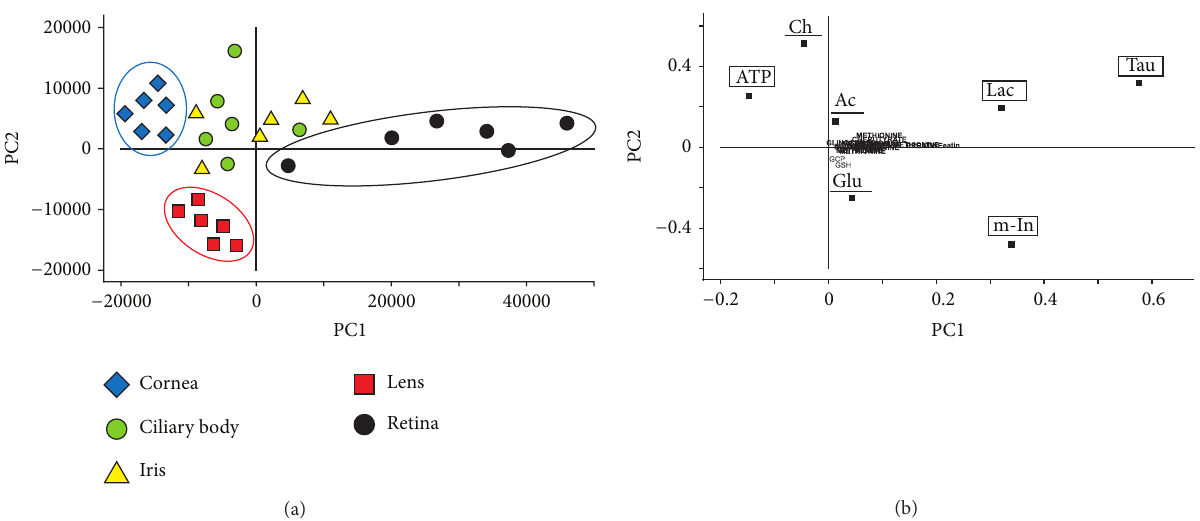
Figure 2: Principal component analysis of human eye tissues. (a) Score plot of the 1st versus the 2nd principal component (PC1 versus PC2) of 1 H NMR spectra. The groupings of the samples were marked with colorful ellipses. (b) Loading profile of the principal components of the 1 H NMR spectra of the eye tissues. Metabolites described in lower cases in the loading profile indicate negligible influence of these compounds on the grouping pattern. The biochemical compounds that served as PC1 were marked with the square frames. The biochemical compounds that served as PC2 were underlined. For metabolite labels see legend for Figure